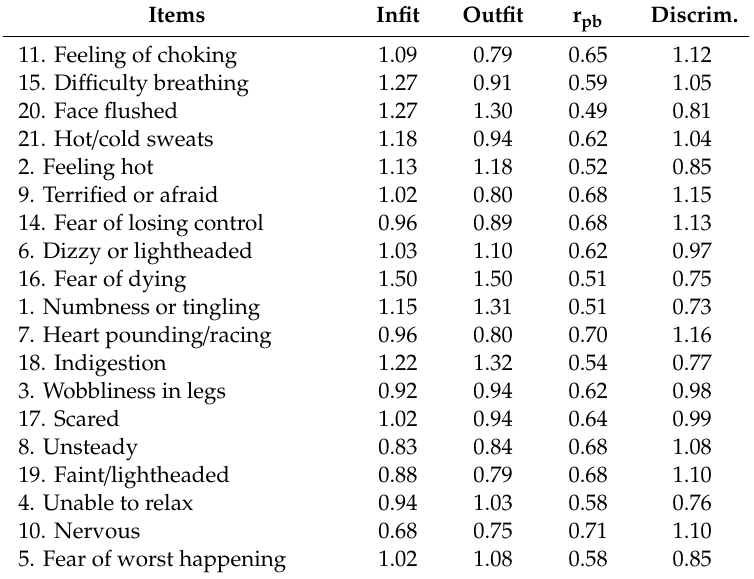
Table 3. Rasch analysis of 19 Beck Anxiety Inventory (BAI) items in the total sample ( n = 445). Items Infit Outfit r pb